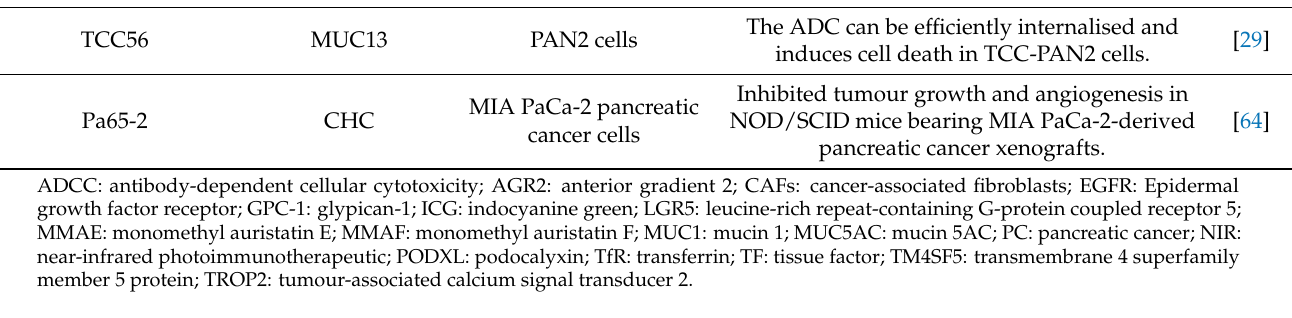
Table 3. Monoclonal antibodies against pancreatic cancer in preclinical studies for use as diagnostic